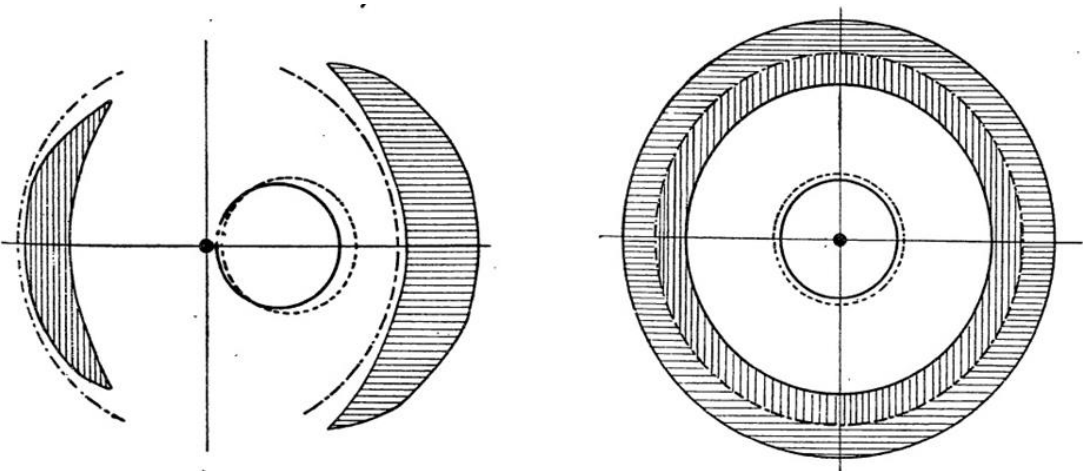
Figure 6. Stages of stellar body (large circle) eclipsing a source (small dot). Shadow areas represent distorted images as seeing them from Earth. Picture taken from [52], source: http://articles.adsabs.harvard.edu/pdf/1937BuAst..10...73L.